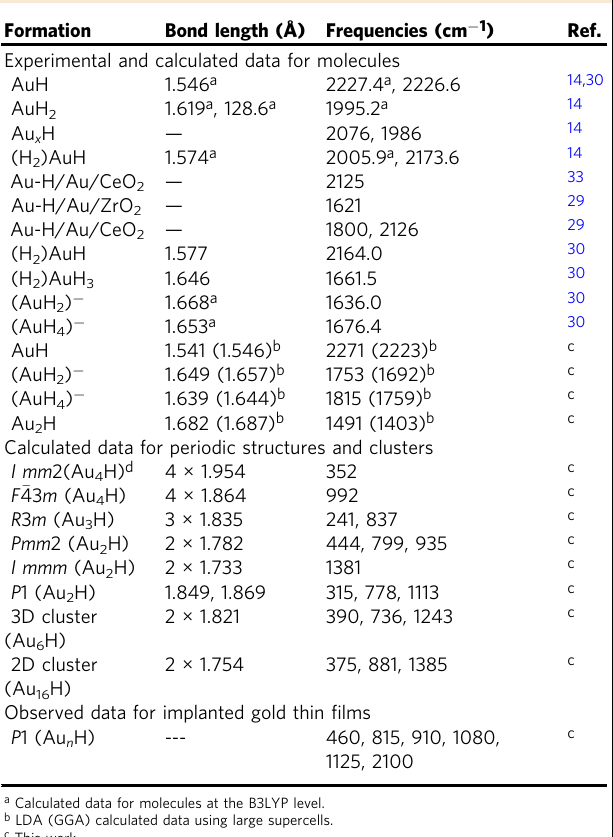
Table 1 Bonding in gold hydrides.